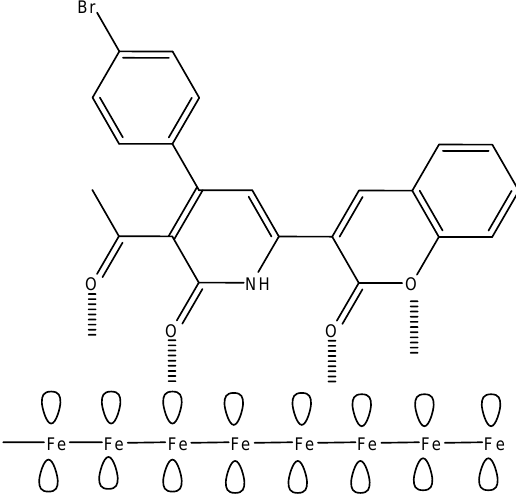
Figure 9: The suggested action on corrosion inhibitor of the ABCP molecule